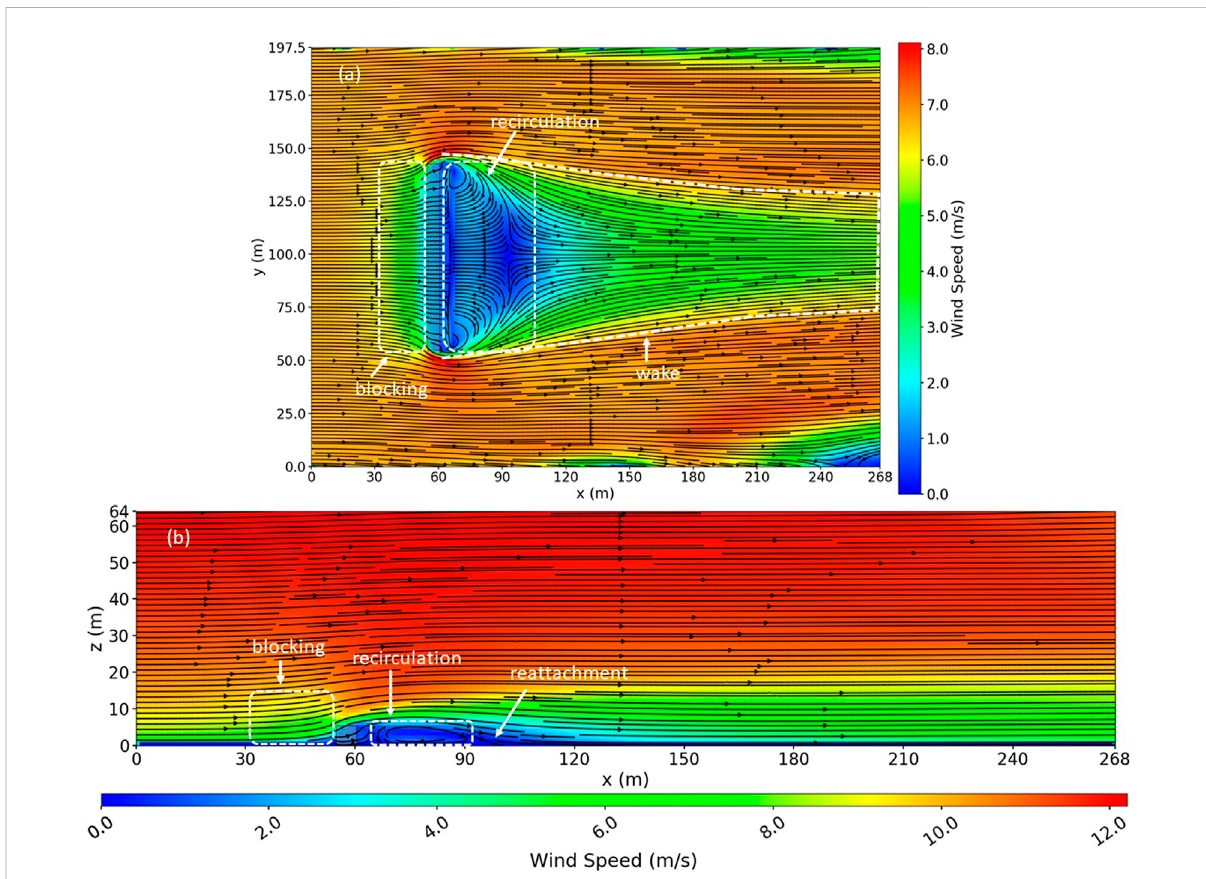
FIGURE 2 Simulated wind fi eld over the vegetation fence without a house in the domain. (A) Top view slice at z = 1.4 m, which is the cell center of the second cell above the ground. (B) Side view slice down the middle of the domain. The dashed lines delineate various fl ow features induced by the fence,includingablockingregionupwind ofthefence,awakeregionofreducedvelocitiesextendingfardownwindofthefence,andarecirculation zone that forms due to fl ow separation behind the fence. The fl ow reattachment zone is also